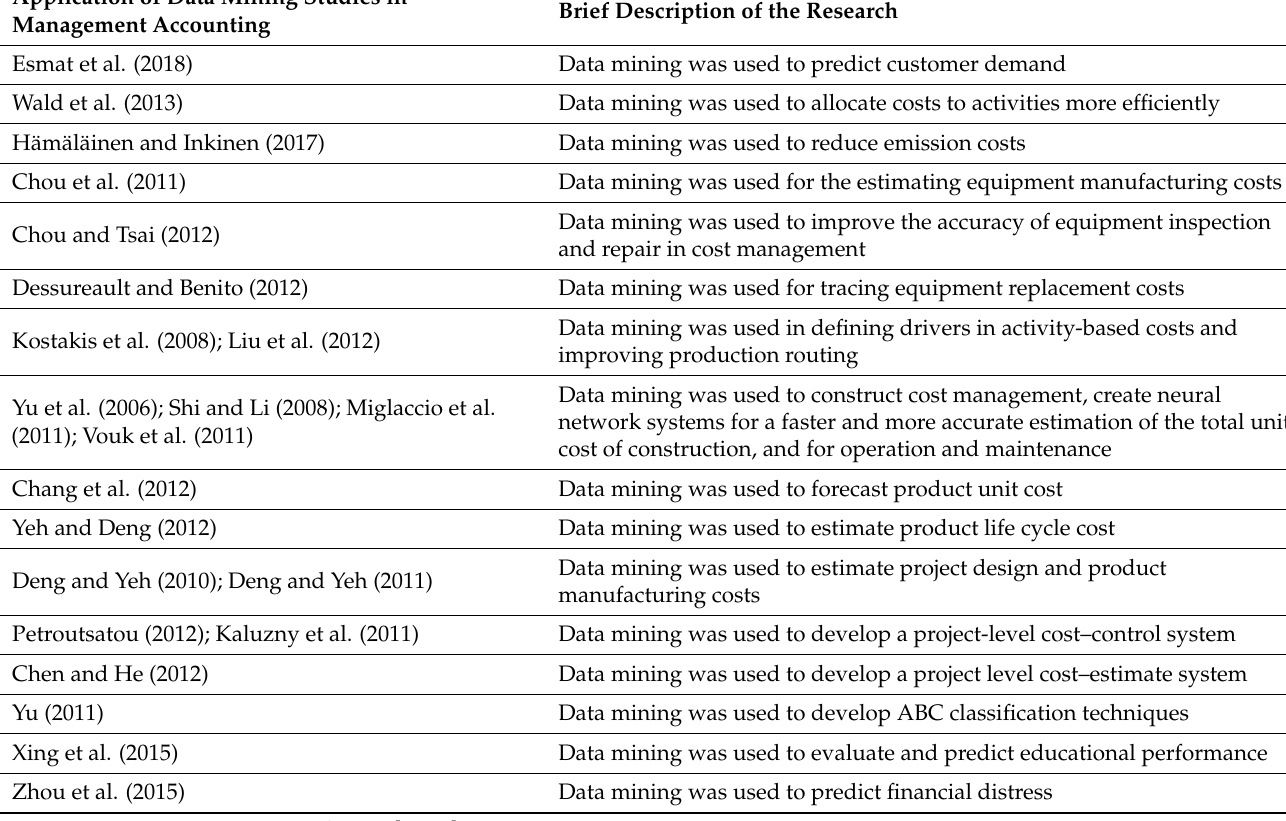
Table 1. Data mining applications within accounting